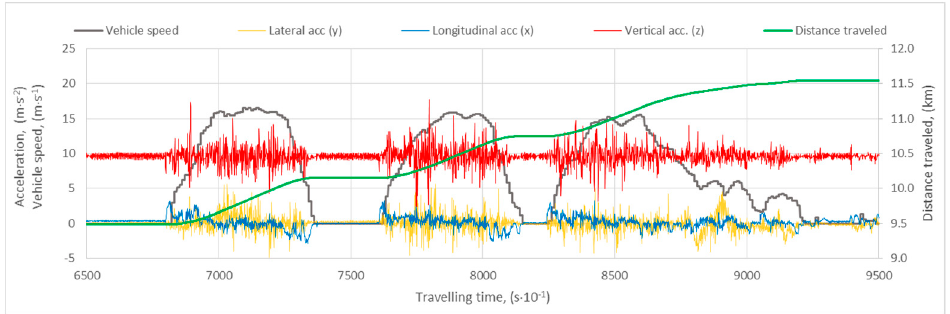
Figure 1. Graph of vibrations (accelerations) of the vehicle loading space on a selected section of the route covered in 5 min in urban conditions in Lublin (own study).